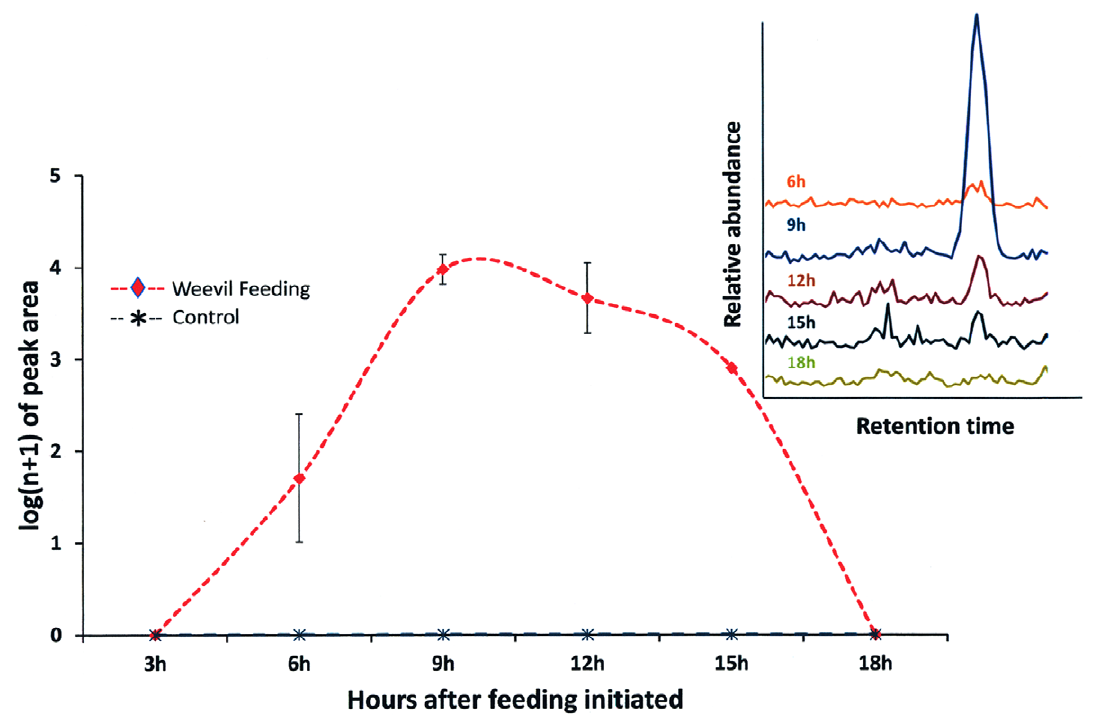
Figure 1. Time course of pregeijerene (1,5-dimethylcyclodeca-1,5,7-triene) release following initiation of weevil ( Diaprepes abbreviatus ) feeding on citrus roots. Insert in the upper right displays chromatogram of volatile abundance at each interval.